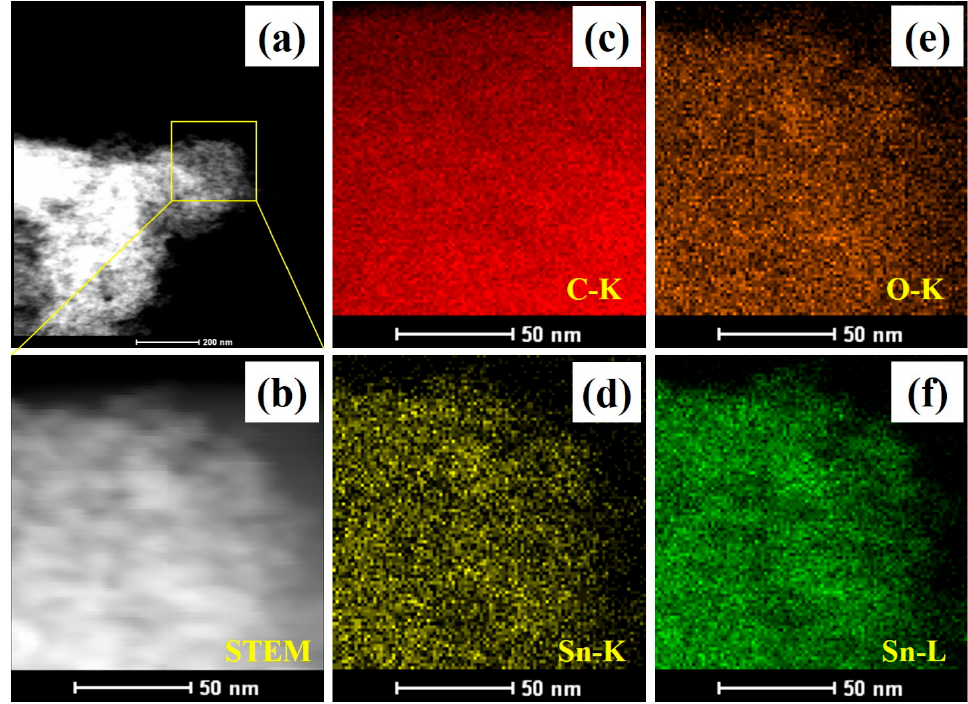
Figure 7. ( a ) TEM, ( b ) STEM, and full elemental mapping images ( c ) C, ( d , f ) Sn, and ( e ) O of SnO 2 -CNFi nanocomposite